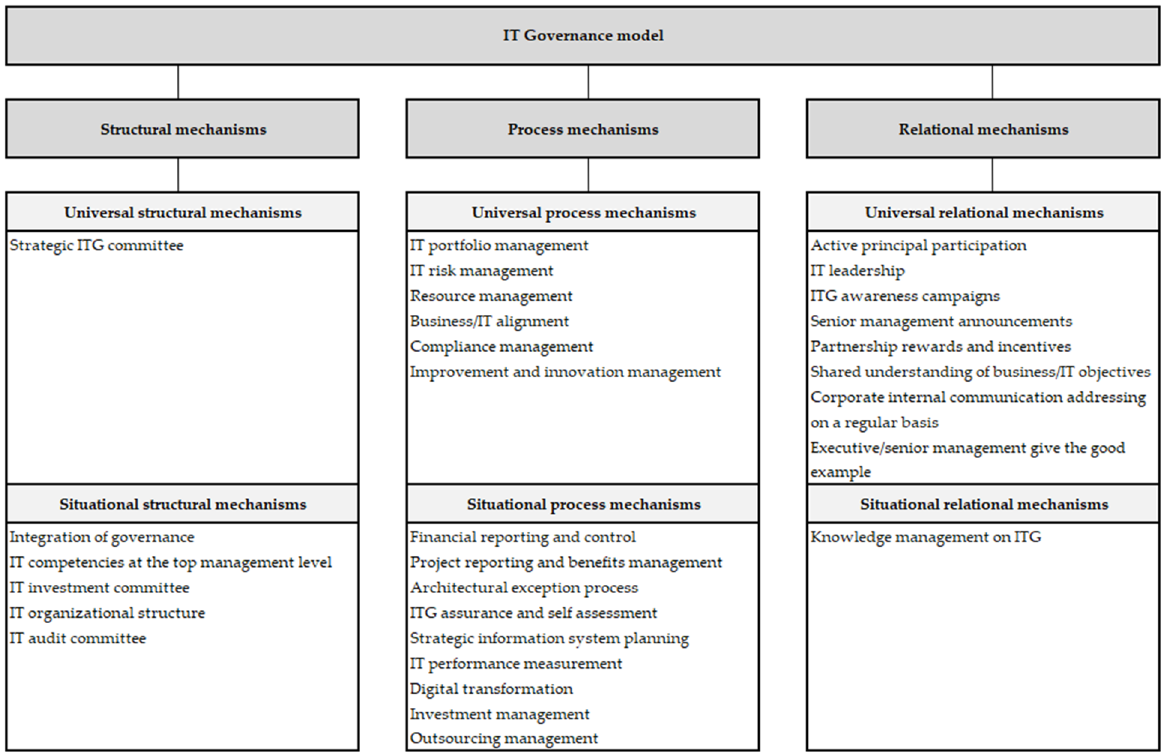
Figure 3. Exploratory ITG model with situational and universal ITG mechanisms .